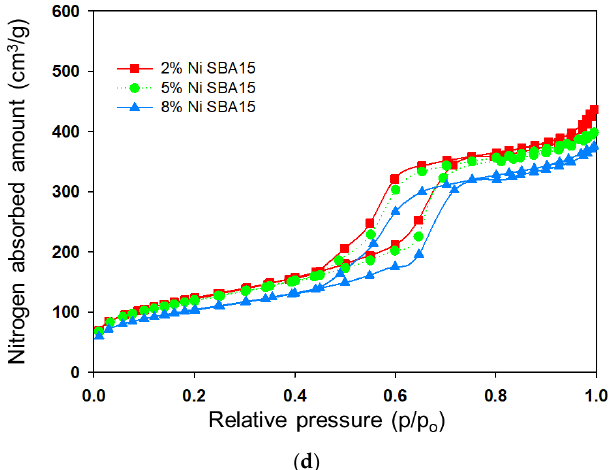
Figure 3. ( a ).Nitrogen adsorption isotherms of SBA-15 and 5 wt% (Fe, Co, Ni)-SBA-15. ( b ).Nitrogen Figure 3. ( a ) Nitrogen adsorption isotherms of SBA-15 and 5 wt% (Fe, Co, Ni)-SBA-15. ( b ) Nitrogen adsorption isotherms of 2 – 8wt% of Fe-SBA-15. ( c ).Nitrogen adsorption isotherms of 2 – 8wt% of adsorption isotherms of 2–8 wt% of Fe-SBA-15. ( c ) Nitrogen adsorption isotherms of 2–8 wt% of Co-SBA-15. ( d ).Nitrogen adsorption isotherms of 2 – 8wt% of Ni-SBA-15. Co-SBA-15. ( d ) Nitrogen adsorption isotherms of 2–8 wt% of Ni-SBA-15.